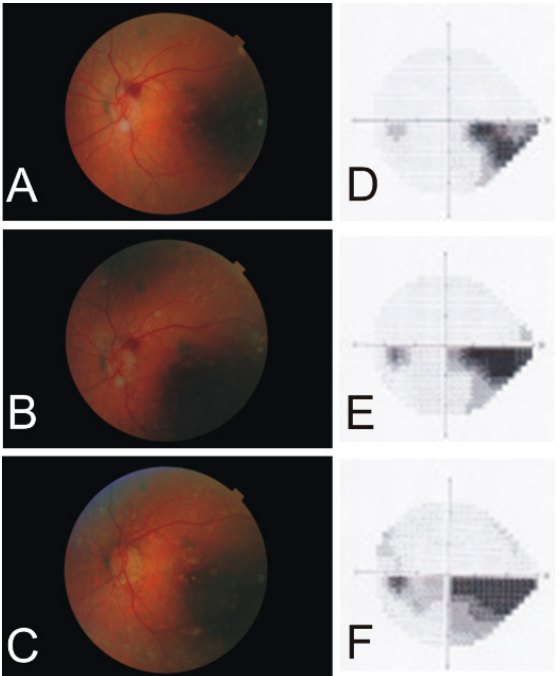
Figure 1. A series of fundus photographs and Humphrey visual fields (24–2) demonstrating the progress of an arteritic ischemic optic neuropathy in the left eye of a 91-year-old female. Note the big red spot next to the optic nerve ( A ), which became smaller after one week ( B ) and disappeared after one month ( C ). The initial scotoma of the inferior temporal quadrant ( D ) increased continuously after one year ( E ) and three years ( F ).